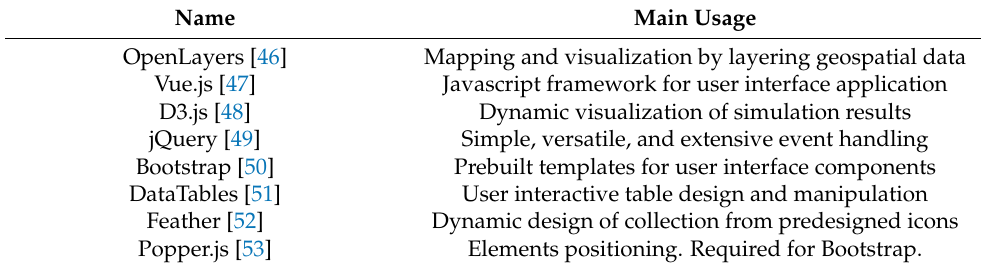
Table 3. Major Javascript Libraries.